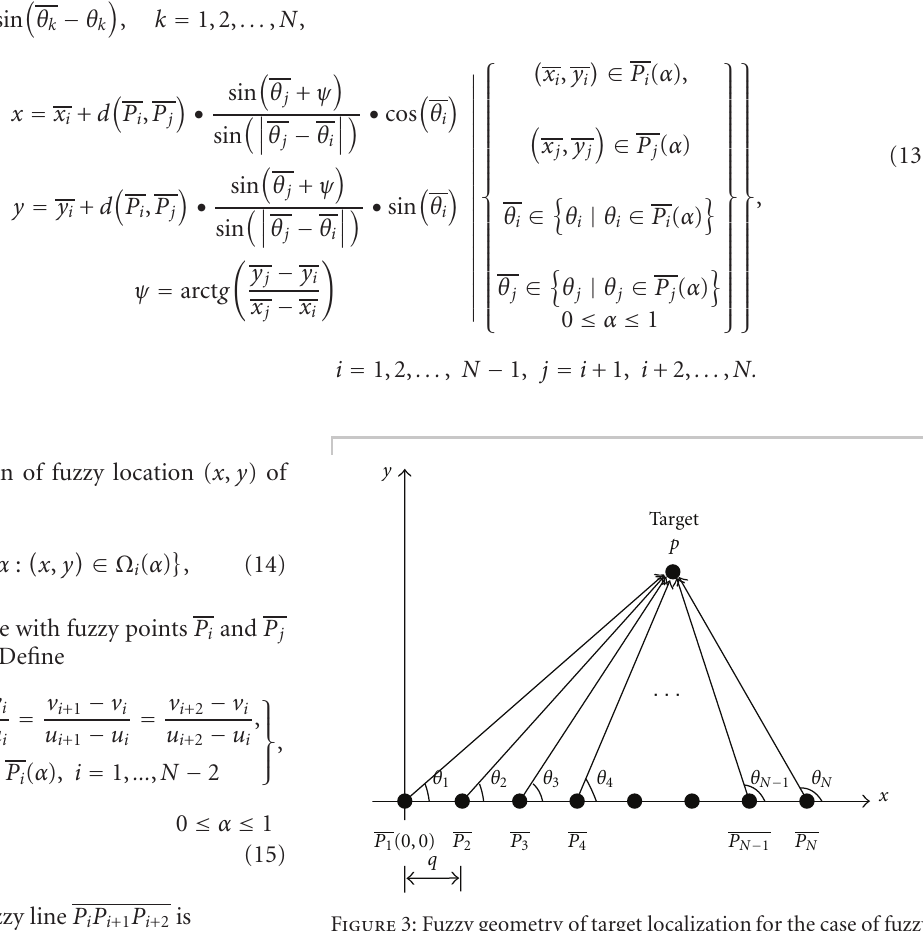
Figure 3: Fuzzy geometry of target localization for the case of fuzzy linear observer